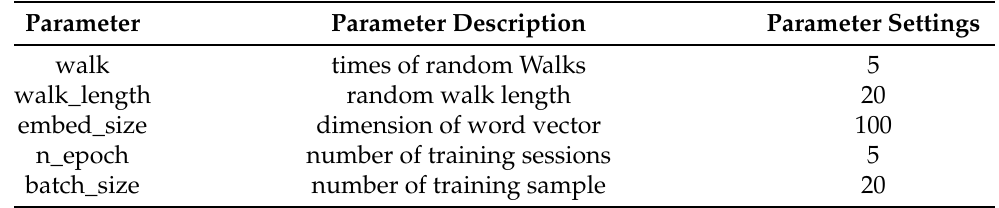
Table 3. Parameter settings of relation vector of training